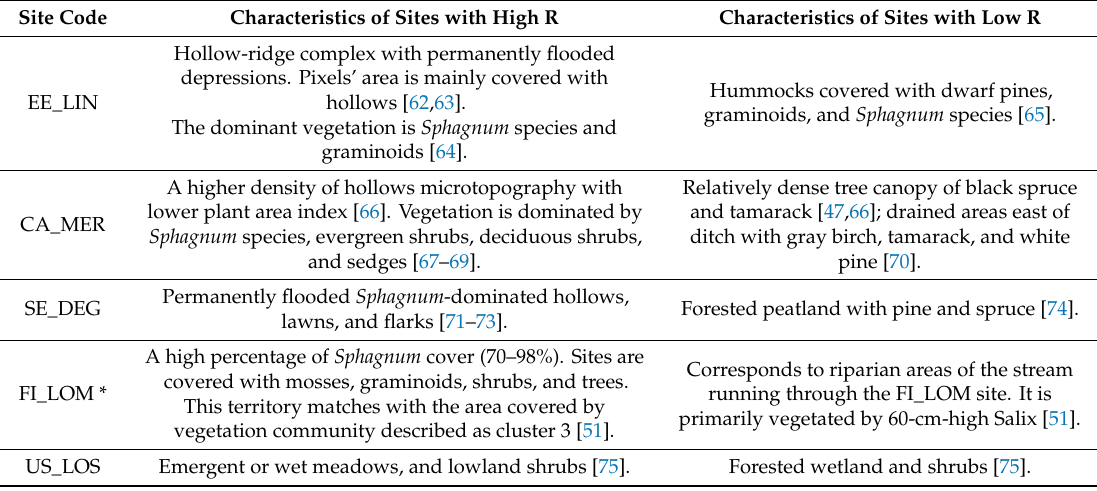
Table 2. Overview of vegetation cover attributed to the high and low correlation between WTD and OPTRAM.